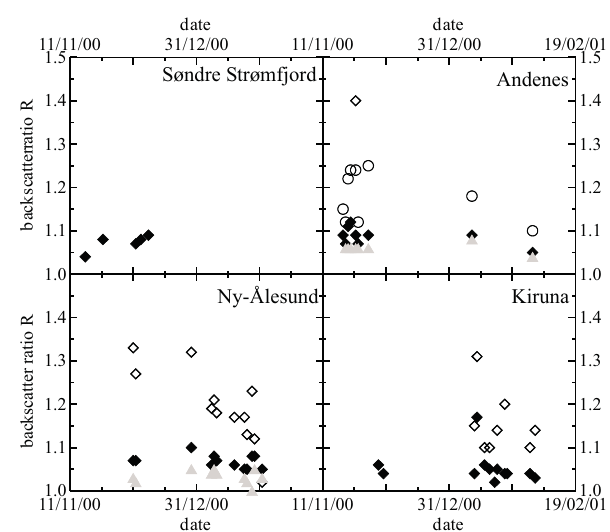
Fig. 3. Altitude of the aerosol layer during winter 2000/2001 (dia- monds). Soundings without findings of the aerosol layer are marked by vertical lines. The grey shaded area marks periods where the polar vortex is not located above the lidar station. Subticks are at five-day intervals.